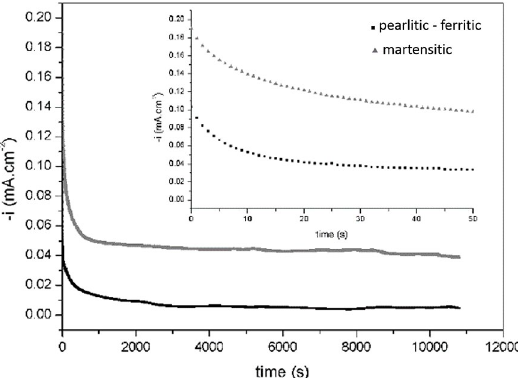
Figure 6. Transients of cathodic current density for each microstructure.